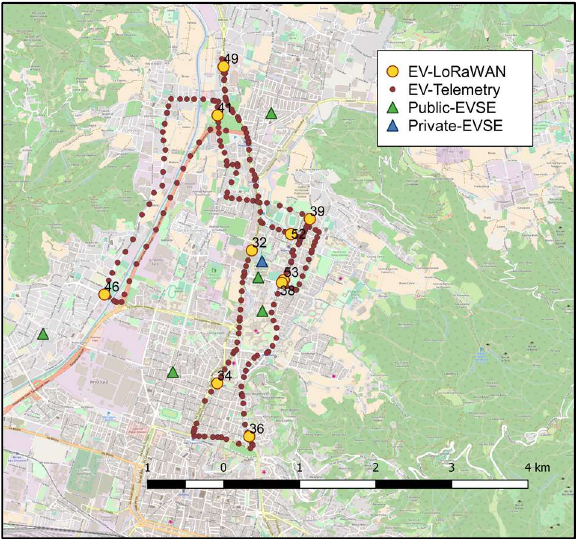
Figure 12. The georeferenced State of Charge (SOC) of the EV, expressed as percentage of the net battery capacity. The yellow circles represent the value of the SOC transmitted to the LoRaWAN infrastructure every 5 min, while the red circles represent the value of the SOC recorded by the on-board telemetry system every 1 s. The experiment was carried out in the city of Brescia, north part of Italy. EV: Electric Vehicle, EVSE: EV Supply Equipment.